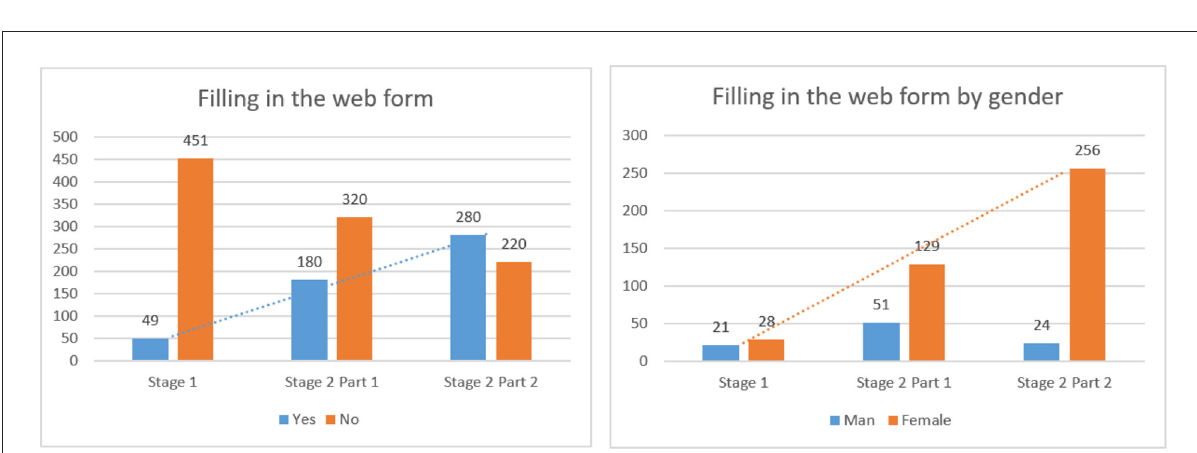
social engineering is to evoke the right feeling with the help of special messages. Messages can have different emotional